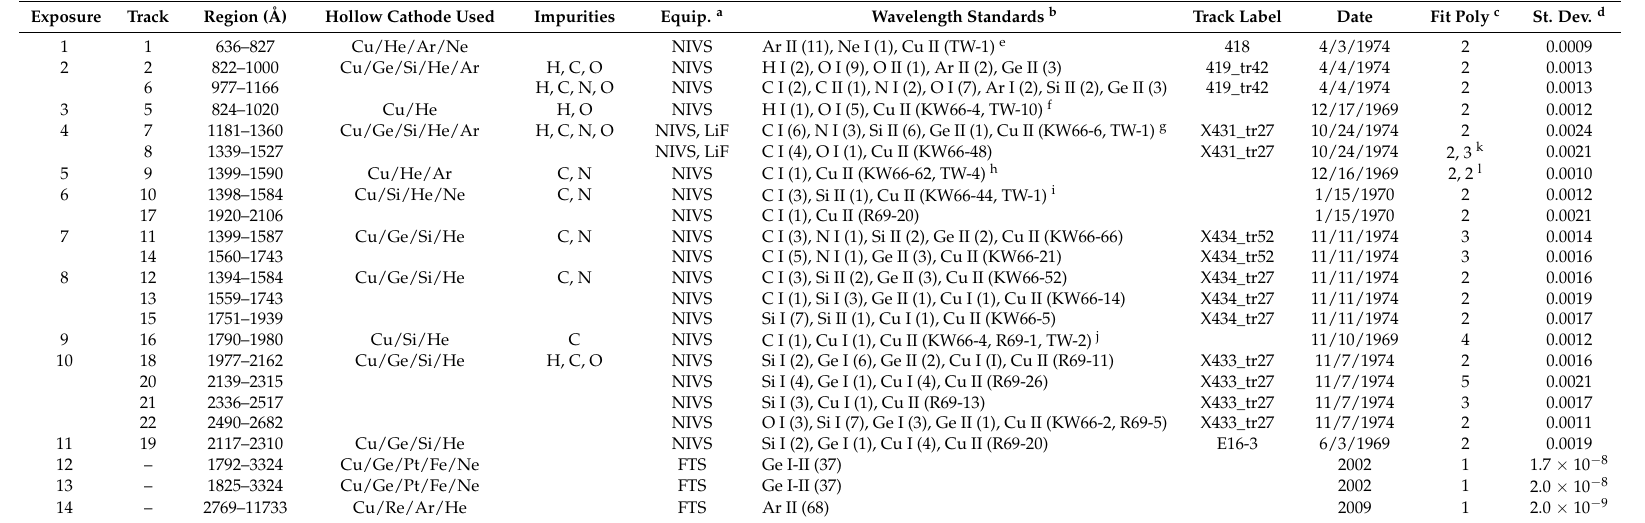
Table 1. Spectrograms used in the present